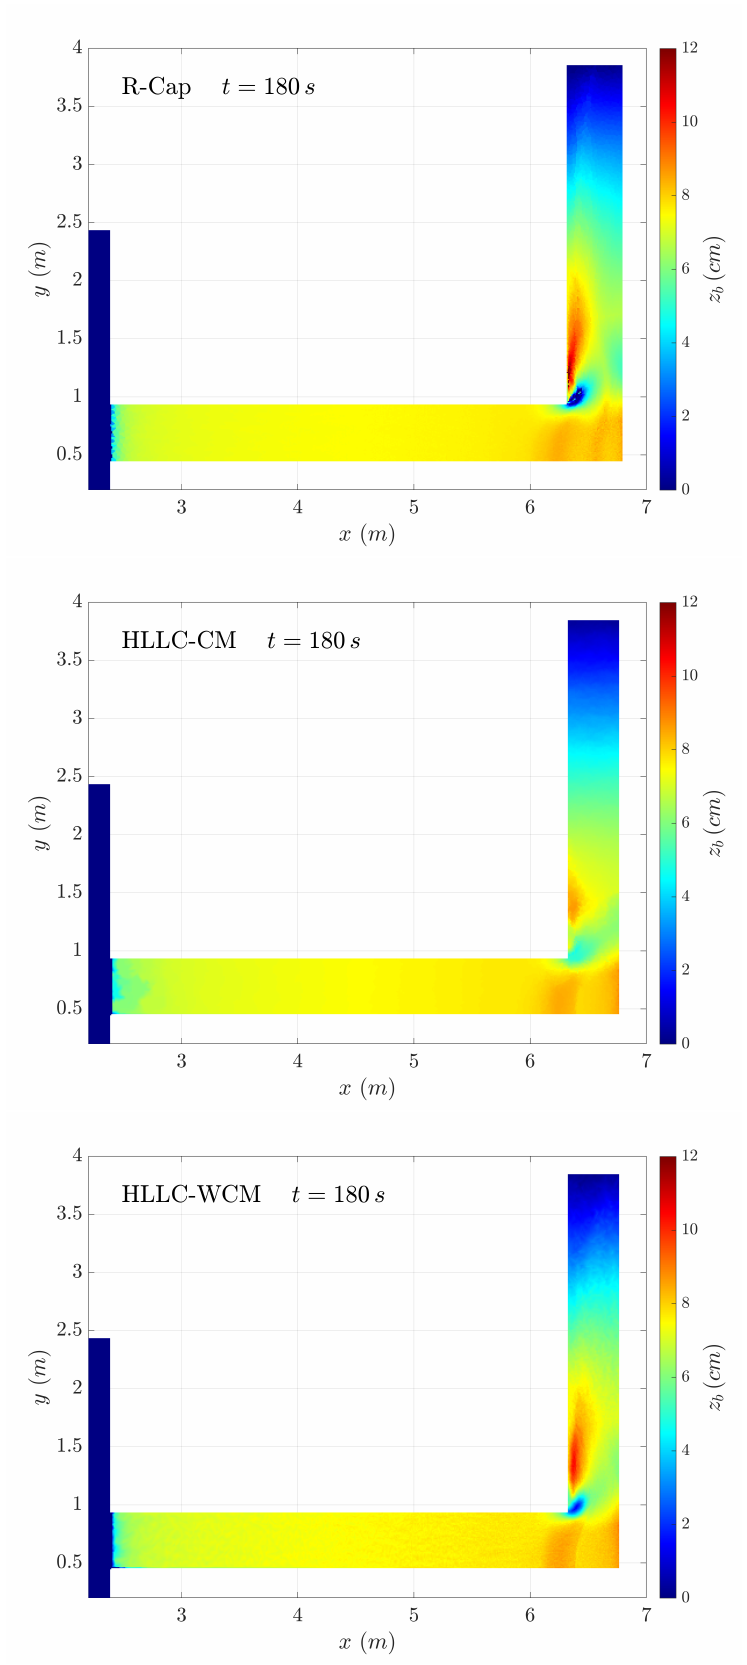
Figure 4. Bed elevation z b 2D maps obtained with the R-Cap- and HLLC-based models at t = 180